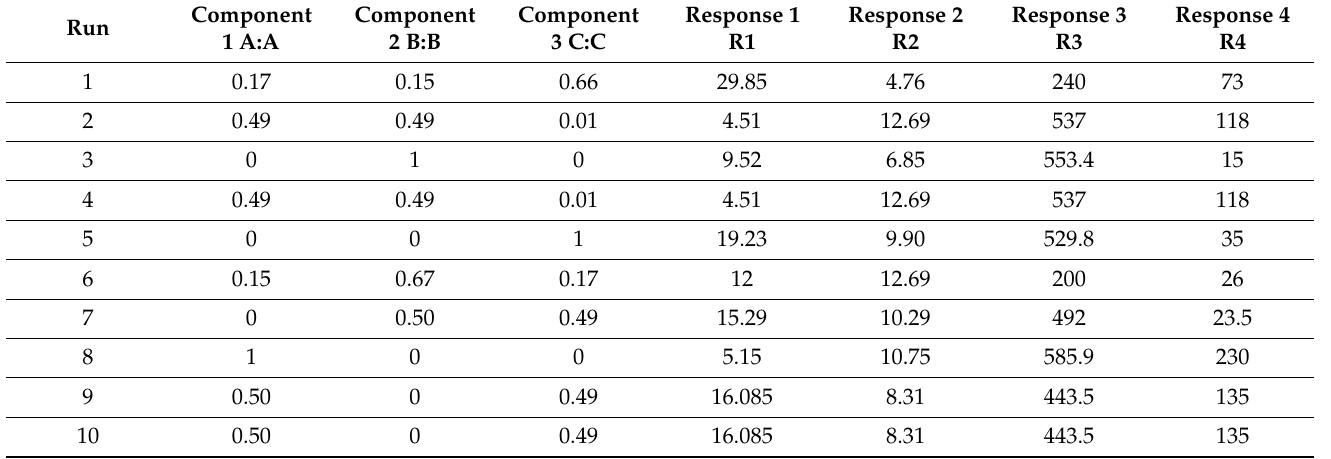
Table 2. Responses of 10 runs comprising a set of different compositions of each component (MCC, starch, Mg silicate). Responses were based on a quadratic polynomial